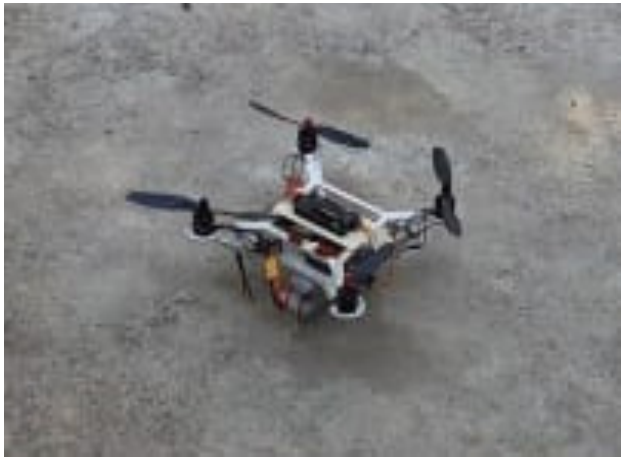
Figure 30. Quadcopter Assembly.